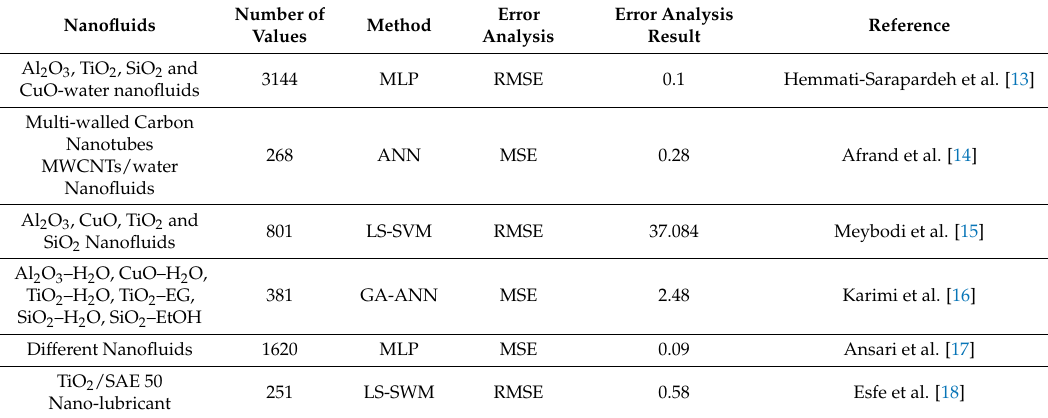
Table 4. The predictive models of nanofluids viscosity in the